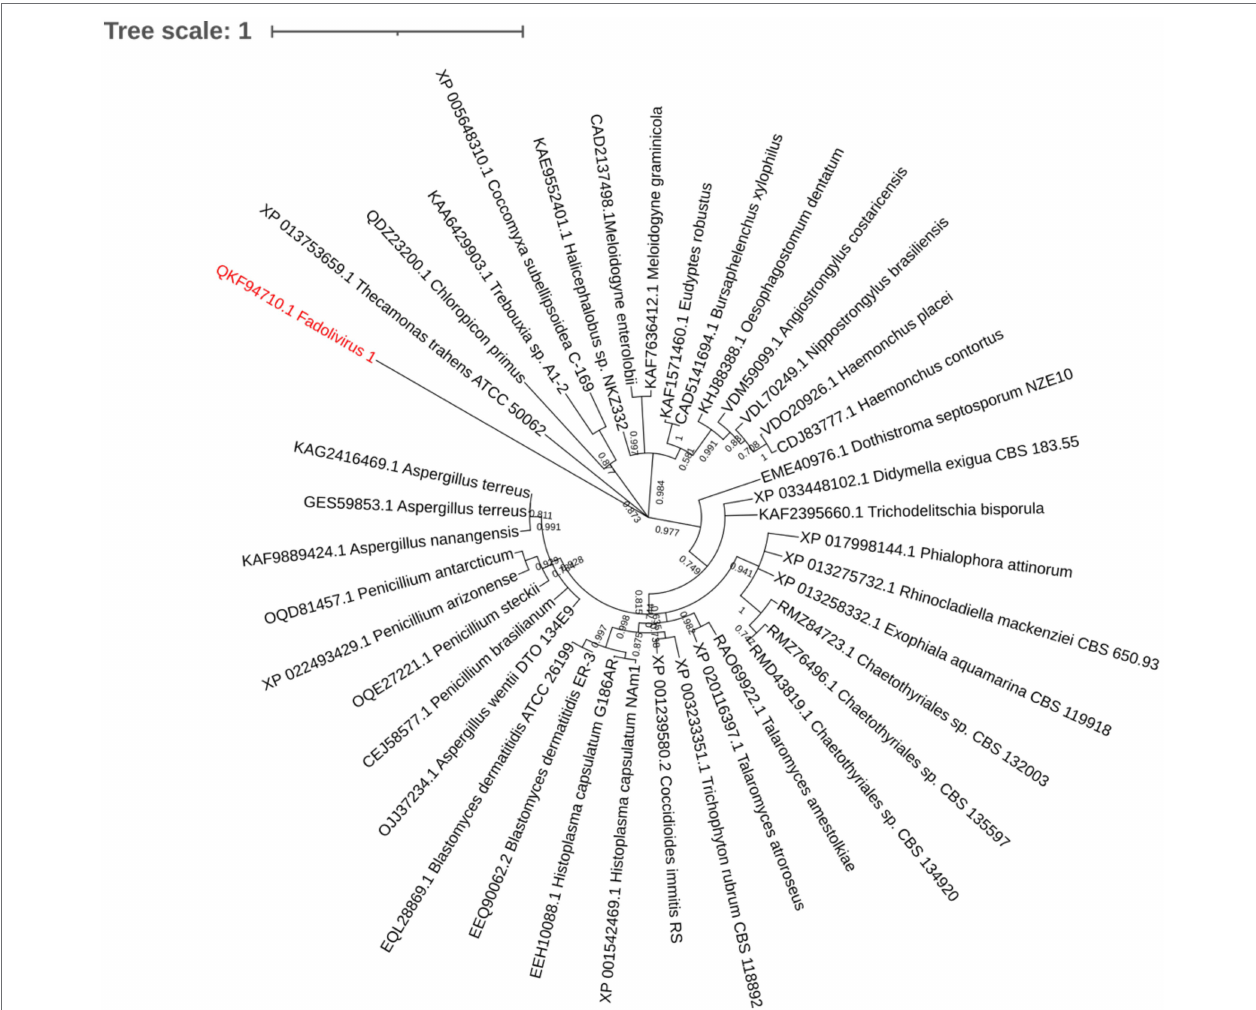
FIGURE 4 | Maximum-likelihood representation built with the Jones–Taylor–Thornton method with 1,000 bootstrap replication based on 286 aligned positions. 39 eukaryote sequences were downloaded as best hit with ATPase from Fadolivirus.